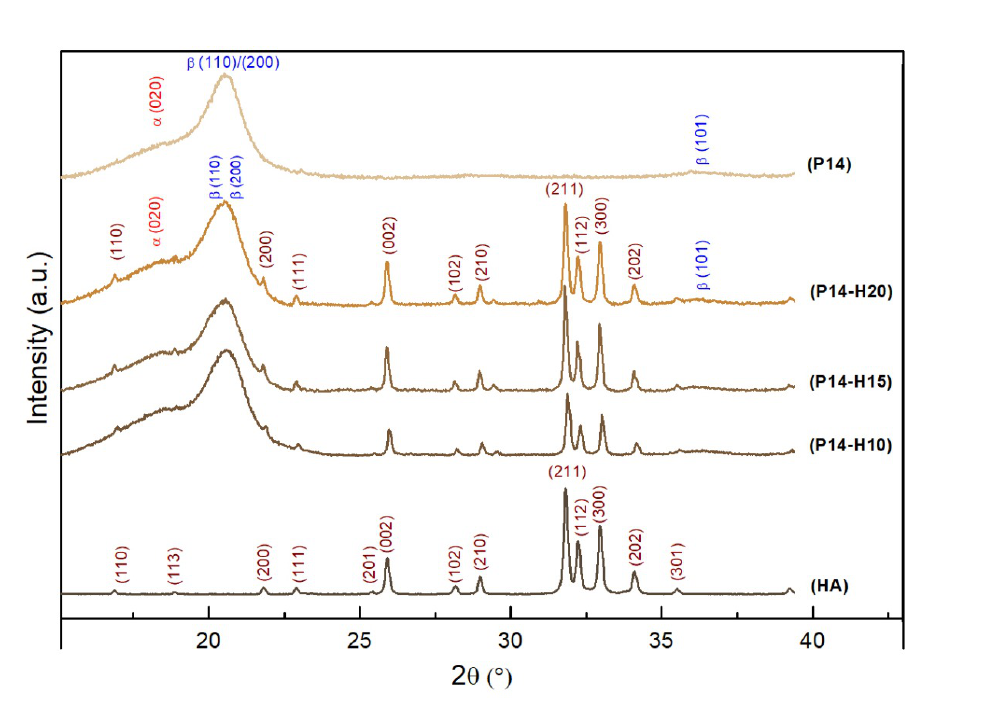
Figure 4. XRD patterns for HA (powder), P14, P14-H10,P14-H15 and P14-H20 (scaffolds)